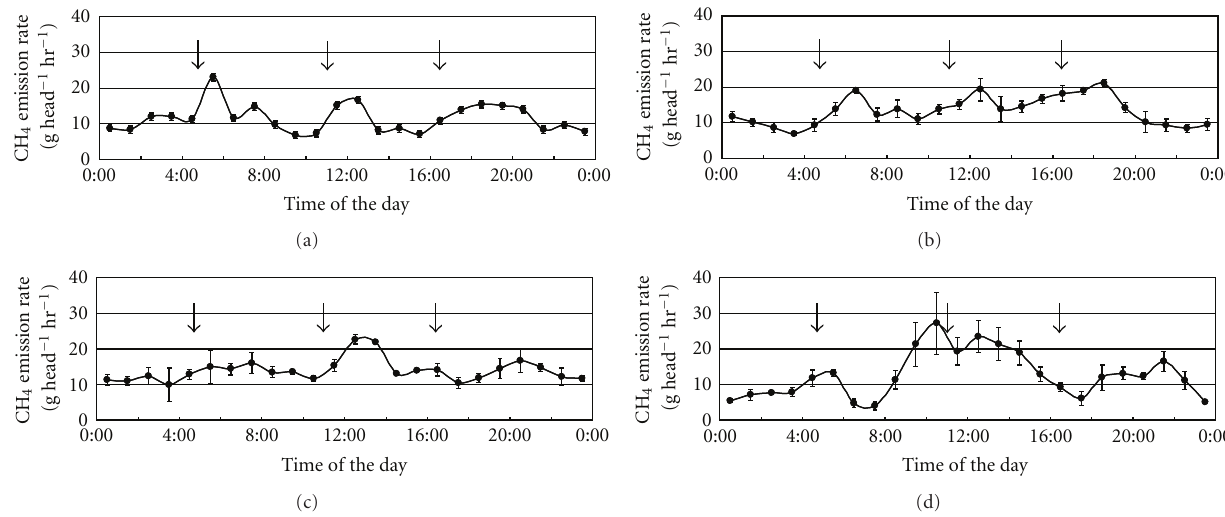
Figure 3: Diurnal patterns of methane emissions over the feedlot during winter (a), spring (b), summer (c), and fall (d) seasons. Bars indicate the uncertainty of hourly averaged methane emission rates and arrows indicate the timing of feeding activities on this feedlot.